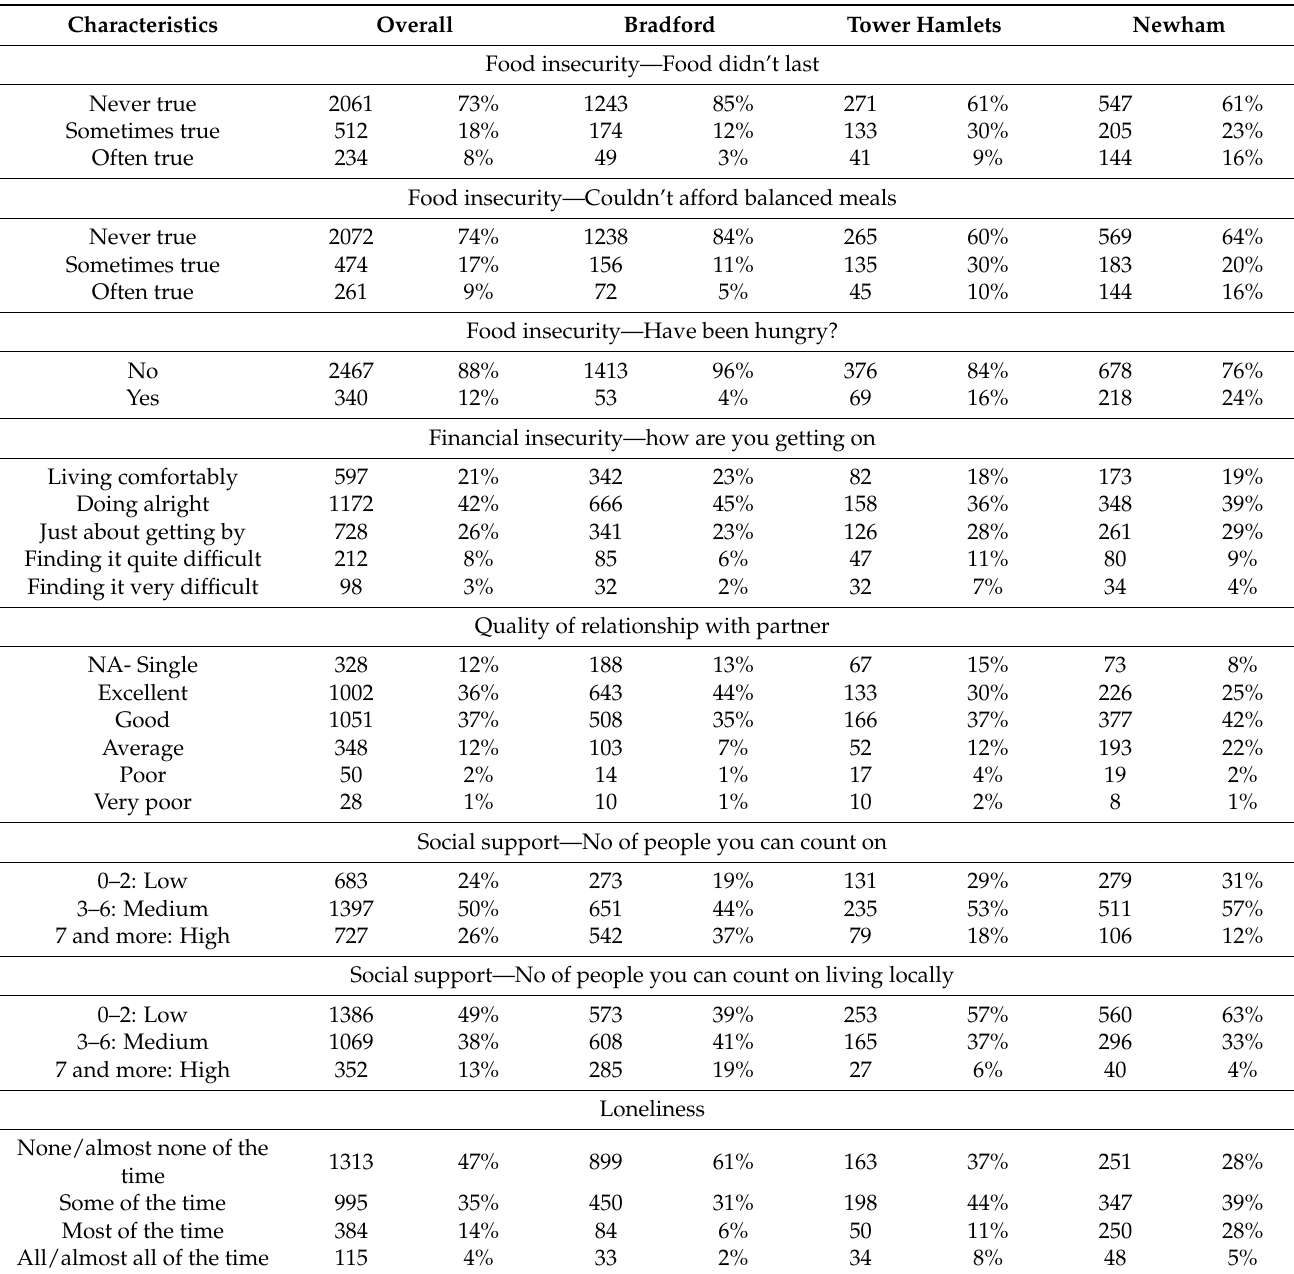
Table 2. Overall, during the COVID-19 pandemic, mothers of Asian/Asian British Pakistani, Bangladeshi and Black/Black British Caribbean/African backgrounds, single mothers, pregnant women, mothers living in damp houses, mothers worried about job security, mothers experiencing food insecurity and financial insecurity, mothers with low levels of social support, and those experiencing loneliness were more likely to experience clinically important